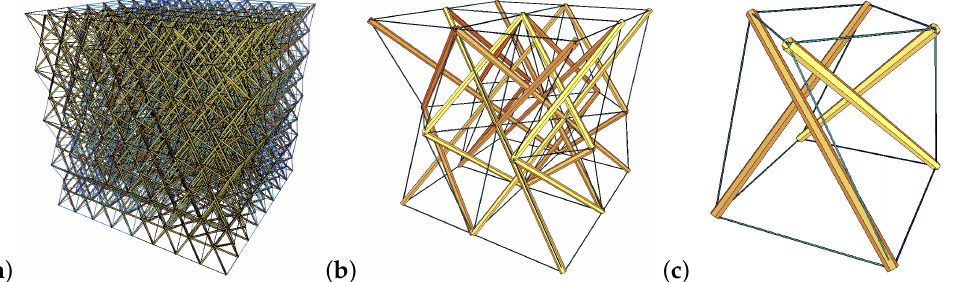
Figure 3. 3D lattice metamaterial based on the tensegrity pattern: ( a ) Micro-scale—material. ( b ) Medium-scale—an 8-module supercell. ( c ) Macro-scale—a unit cell. Struts are marked with yellow color and cables with thin blue